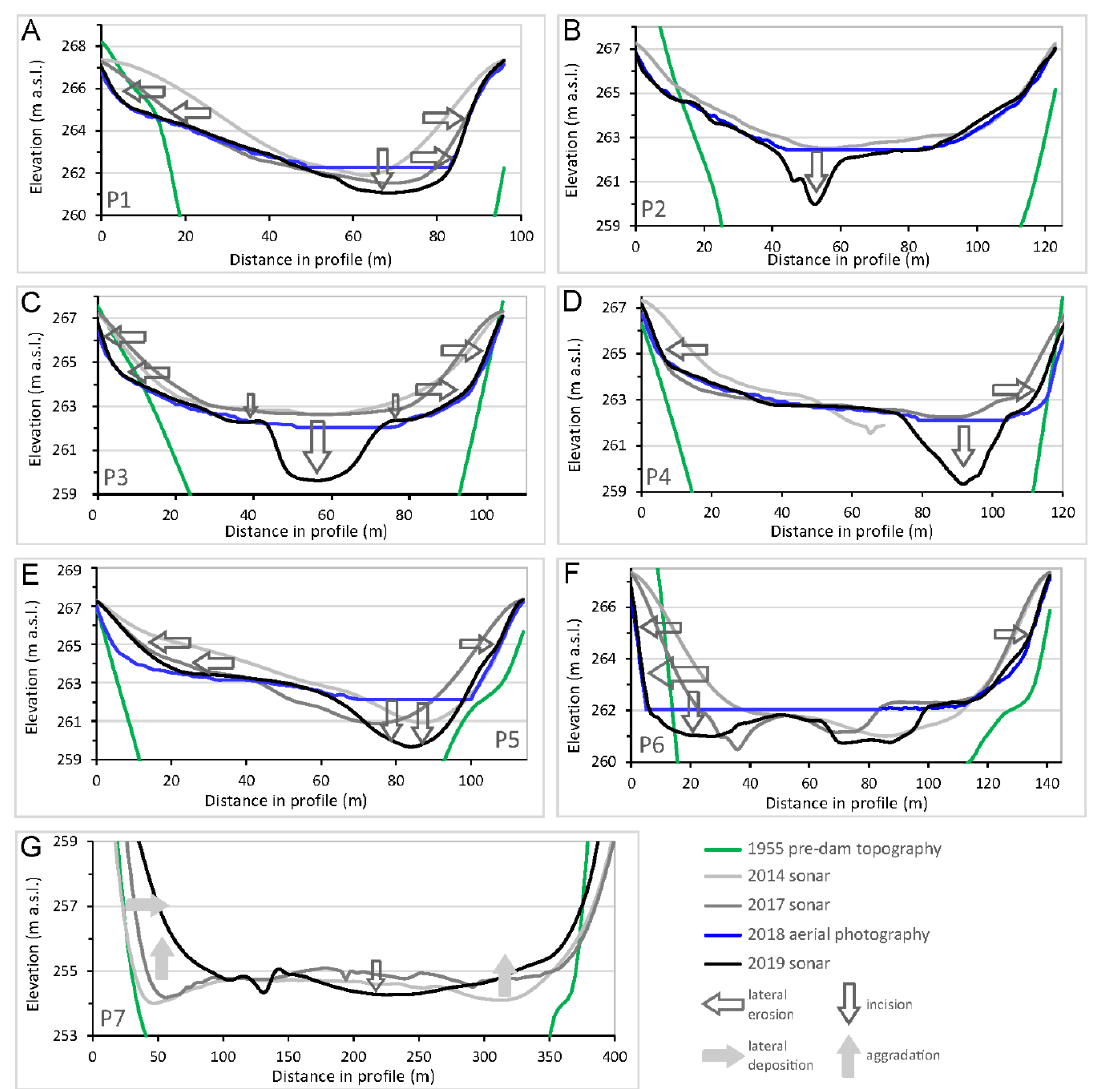
Figure 9. Elevation changes in selected profiles through the Nechranice inflow. ( A ) Profile P1, ( B ) profile P2, ( C ) profile P3, ( D ) profile P4, ( E ) profile P5, ( F ) profile P6, ( G ) profile P7.